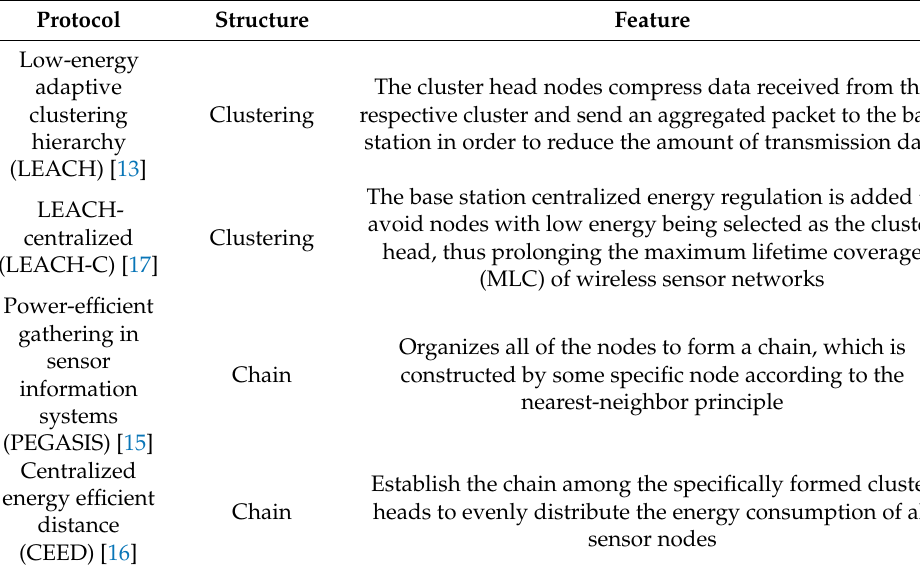
Table 1. Comparison of the conventional routing